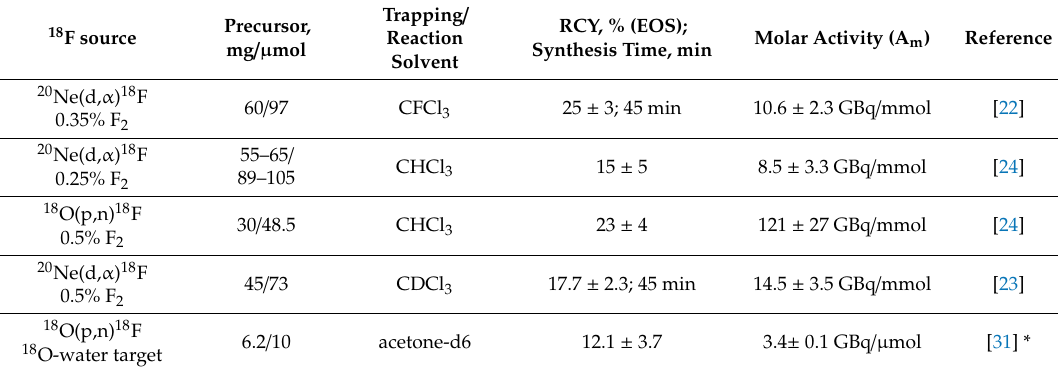
Table 1. Synthesis of 6- l -[ 18 F]FDOPA via electrophilic radiofluorination of arylstannane precursor (R = CHO, Scheme